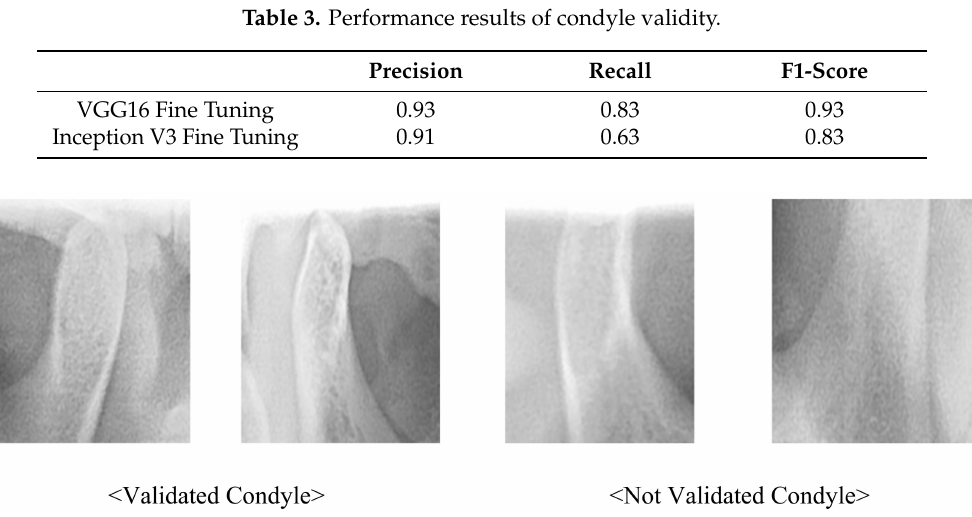
Figure 7. Examples of validated and not validated